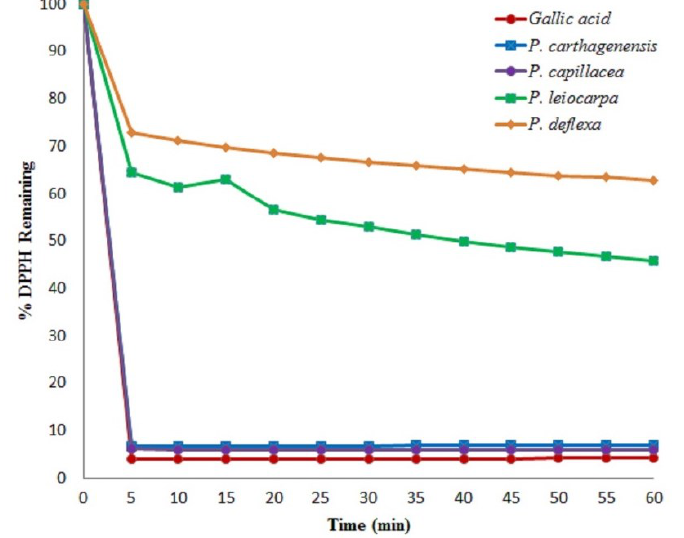
Figure 1. Kinetic behavior